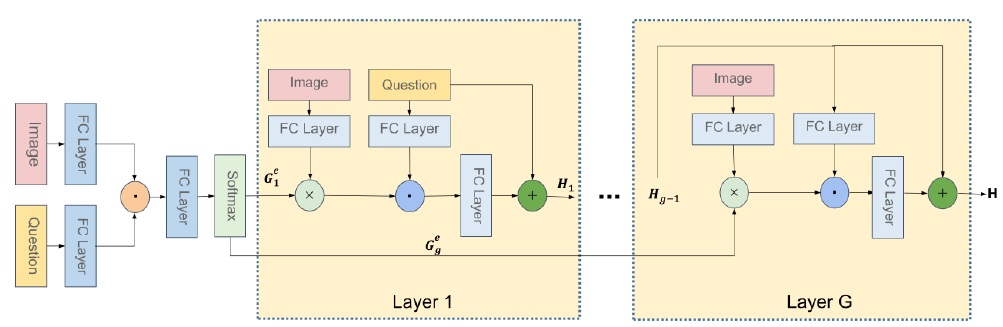
Figure 3. Architecture of our Multi-glimpse Bilinear Guided-Attention